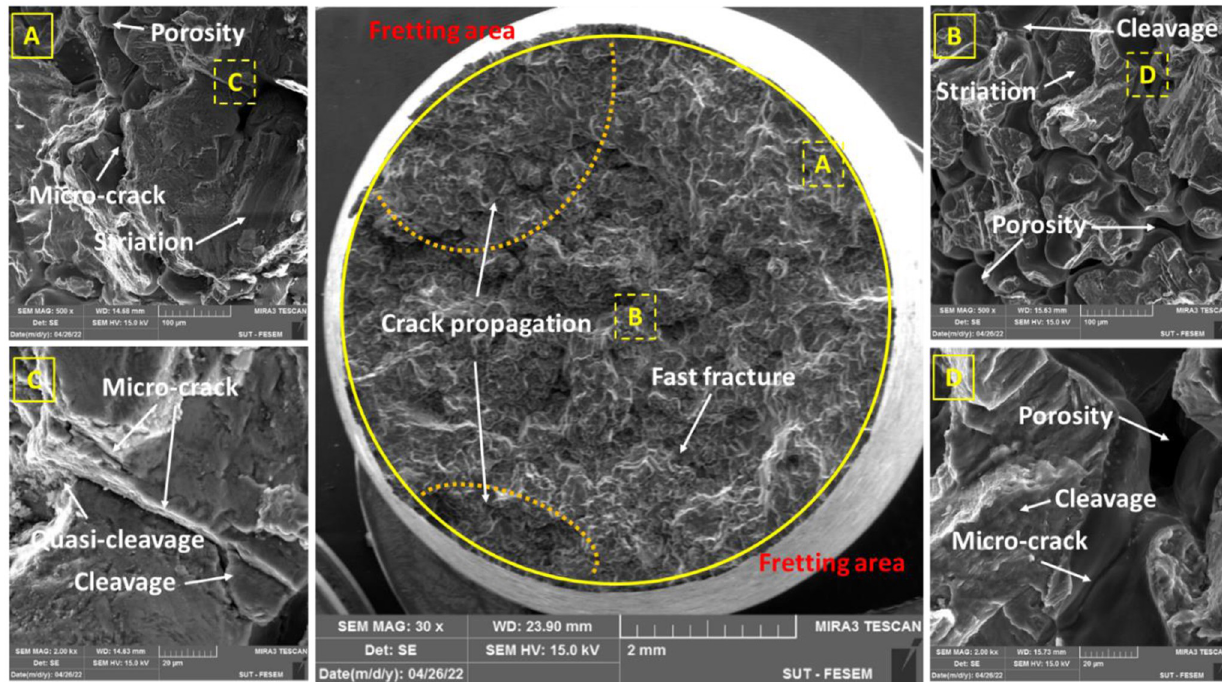
Fig 10. The fracture surface under fretting fatigue conditions (the stress level: 120 MPa).